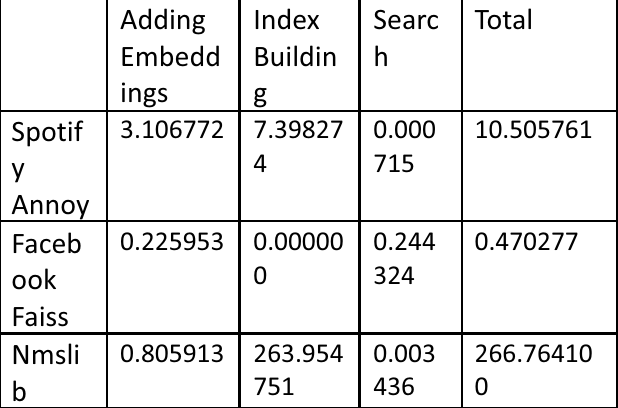
fig 9: Benchmarks for